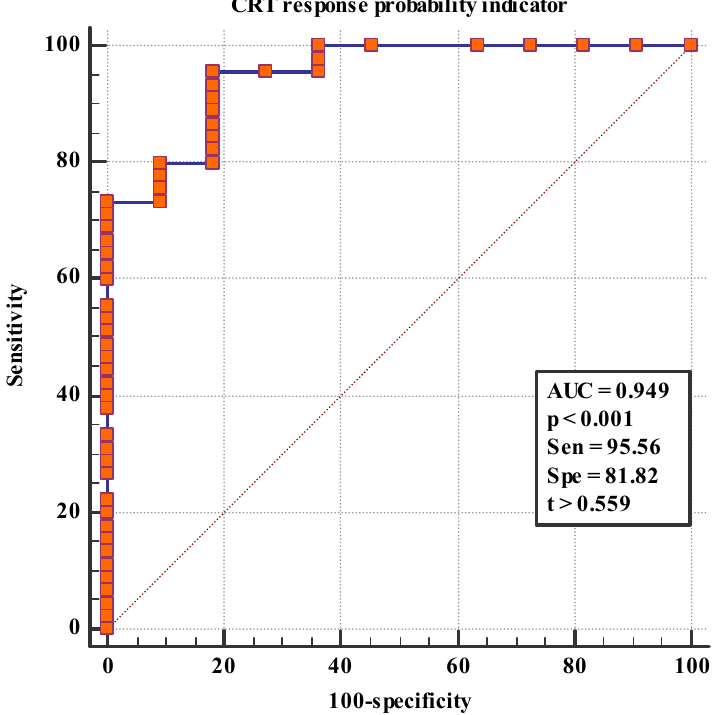
Figure 2. CRT response probability indicator, calculated according to the predictive model. AUC— area under the curve, Sen—sensitivity, Spe—specificity, t—threshold value.